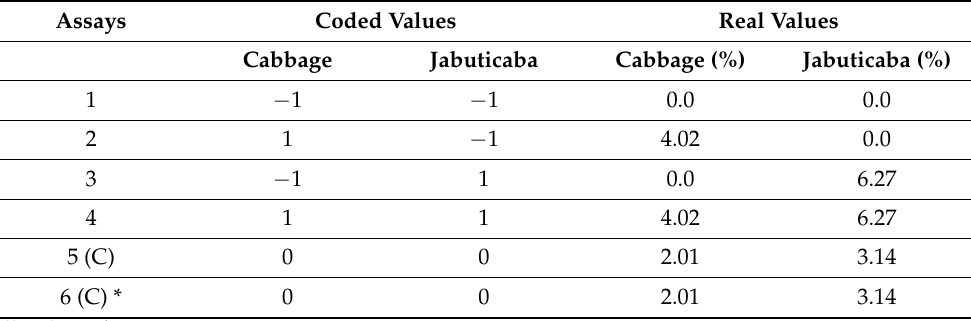
Table 1. Factors and respective levels ( − 1 for the minimum concentration, +1 for the maximum and zero for the center point) of the variables of red cabbage stirs and jabuticaba peels extracts, coded and real values (in total solids %). Assays Coded Values Real Values Cabbage